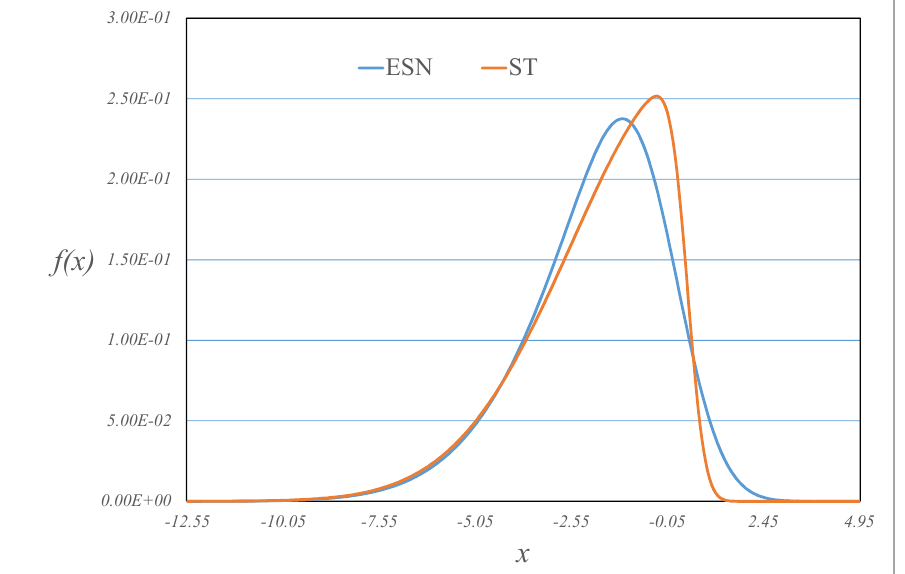
Figure 13. Example of an extended skew-normal and approximating skew-Student density functions.